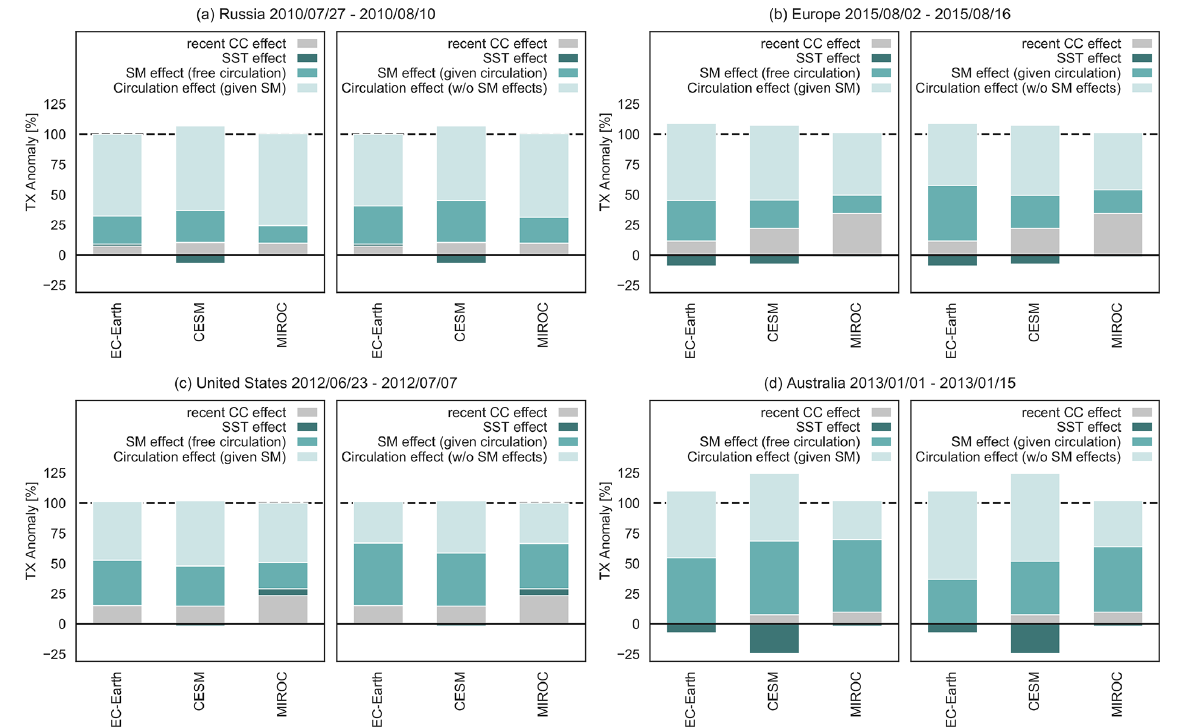
Figure A8. Same as Fig. 7 but showing the separate effects for the two approaches to compute SM vs. ATM contributions (left A, right B).